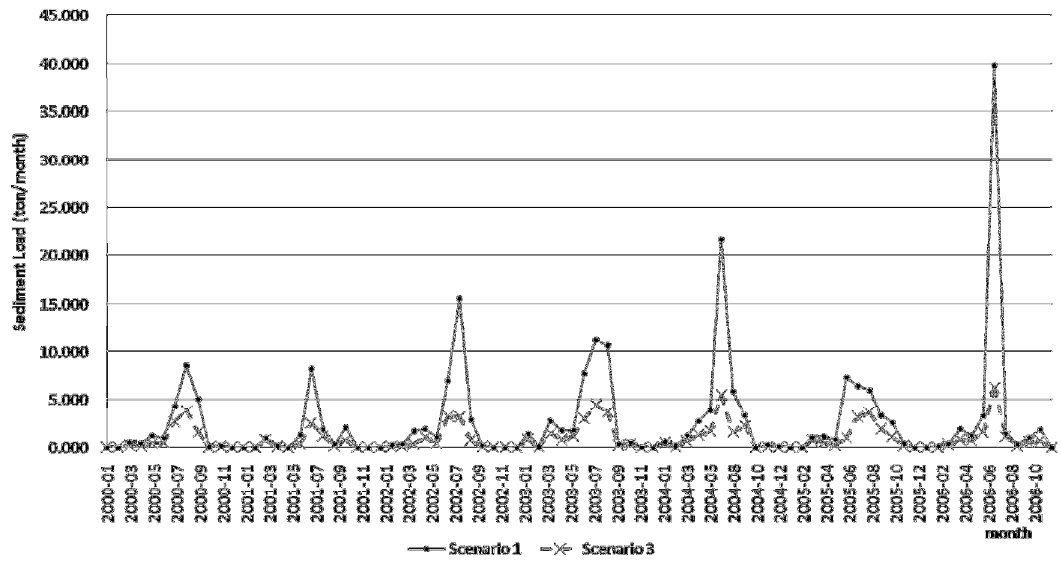
Figure 16. Comparison of Simulated Monthly Sediment for Scenarios 1 and